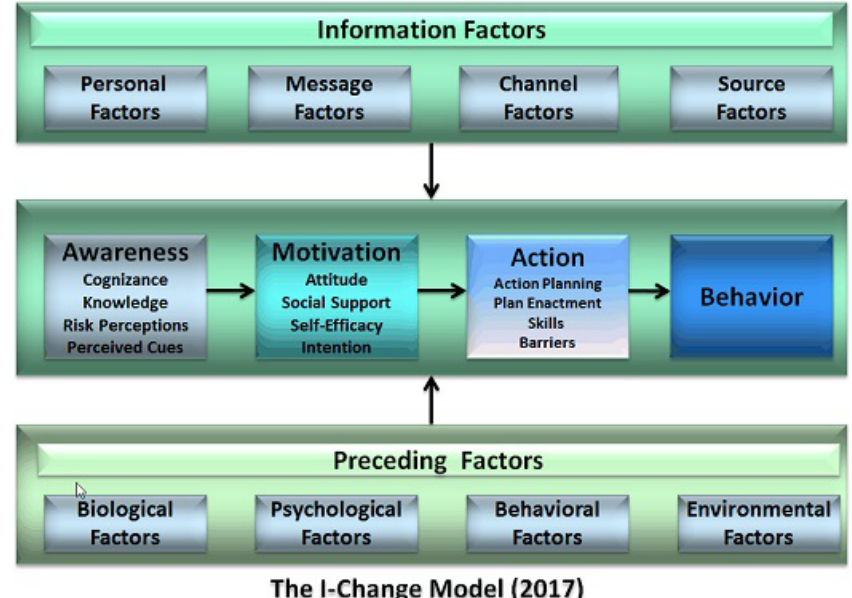
Figure 2. I-Change behavior change model [25].